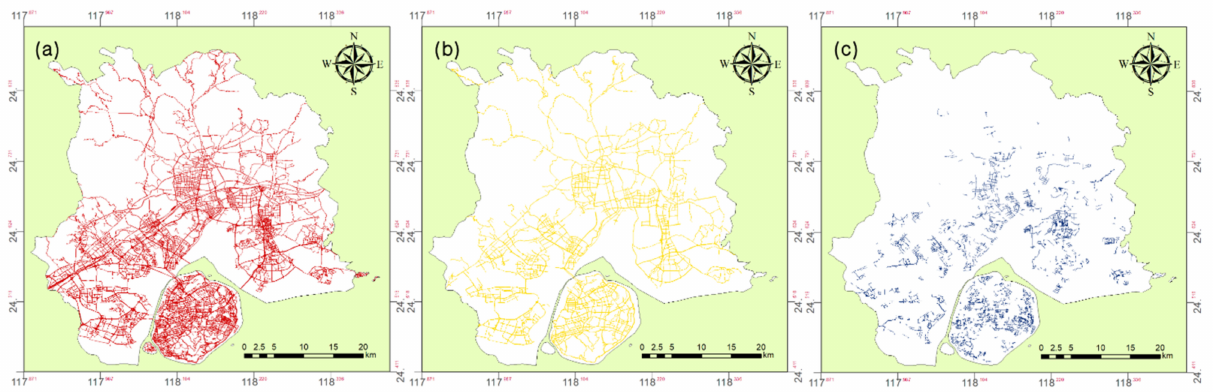
Figure 5. Road data of Xiamen: ( a ) all roads; ( b ) primary/secondary/tertiary roads; and ( c ) residential roads.